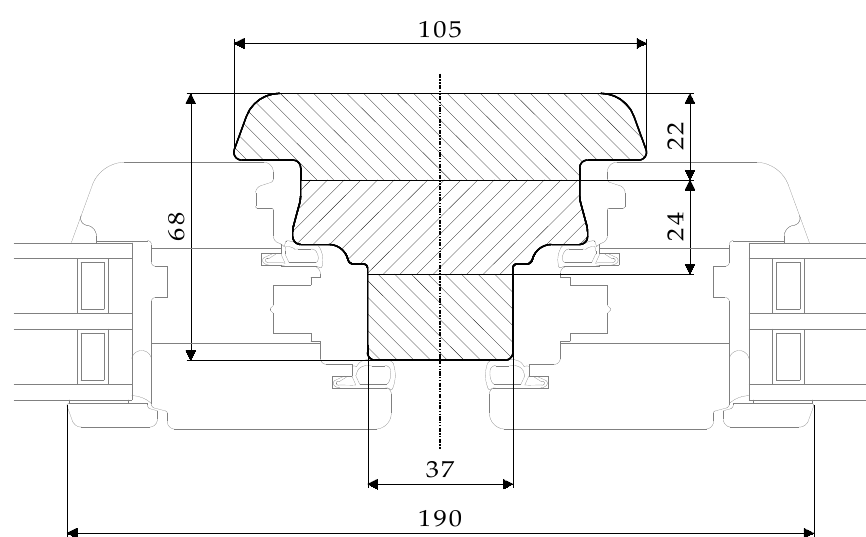
Figure 14. Mullion‐middle fixed element of the double sashed window (measurements in mm).